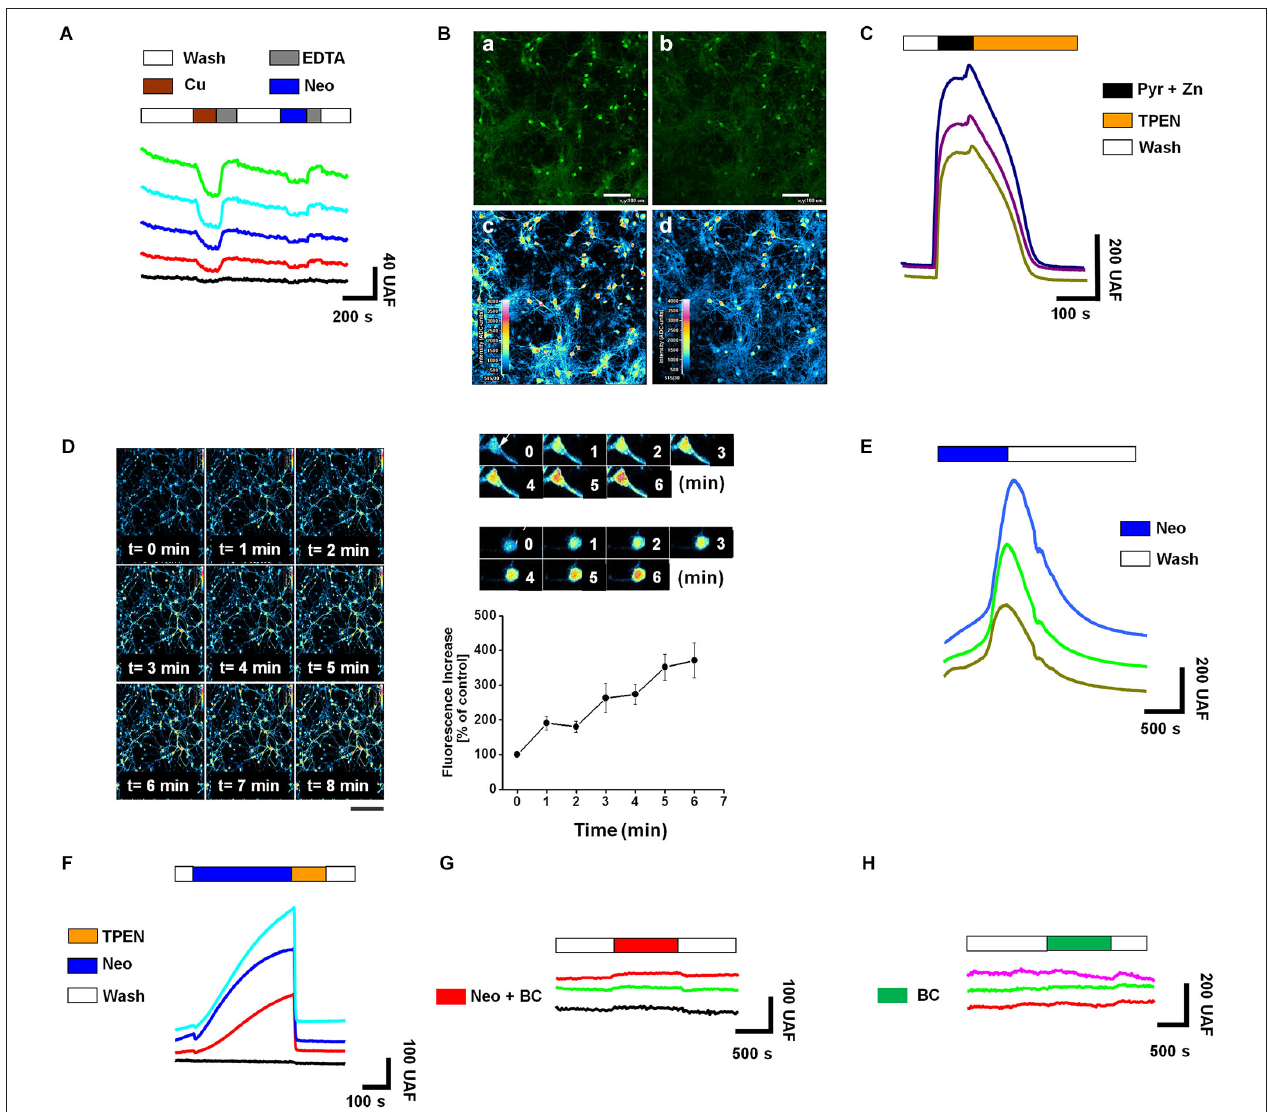
corresponds to the signal recorded in a single cell. (D) Confocal microphotographs of hippocampal cultures loaded with FluoZin-3, before (time = 0) and after of a short application (up to 8 min) of Neo (10 µ M). Scale bar, 250 µ m. At the right of this panel is shown a confocal zoom of two neurons from the experiment described in “ (D) ”. The graph summarizes the intracellular Zn 2 + changes recorded in the soma of single neurons treated as shown in “ (D) ”. Values are mean ± SEM ( N = 3). (E) The traces show the rapid intracellular changes of FluoZin-3 fluorescence after the acute application of Neocuproine (Neo, 10 µ M). (F–H) Each colored trace corresponds to the FluoZin-3 fluorescent signal recorded on the soma of single hippocampal neuron under the treatments indicated in the figures (Neocuproine, Neo = 10 µ M; Bathocuproine, BC = 10 µ M; TPEN = 10 µ M). The black traces correspond to the typical background signal recorded outside of